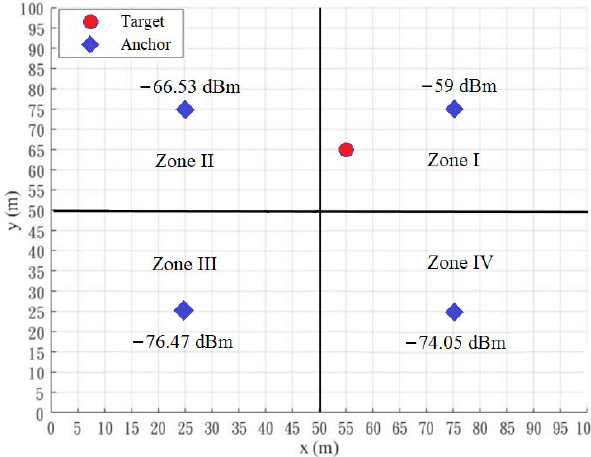
Figure 5. Illustration of RSM region judgment.